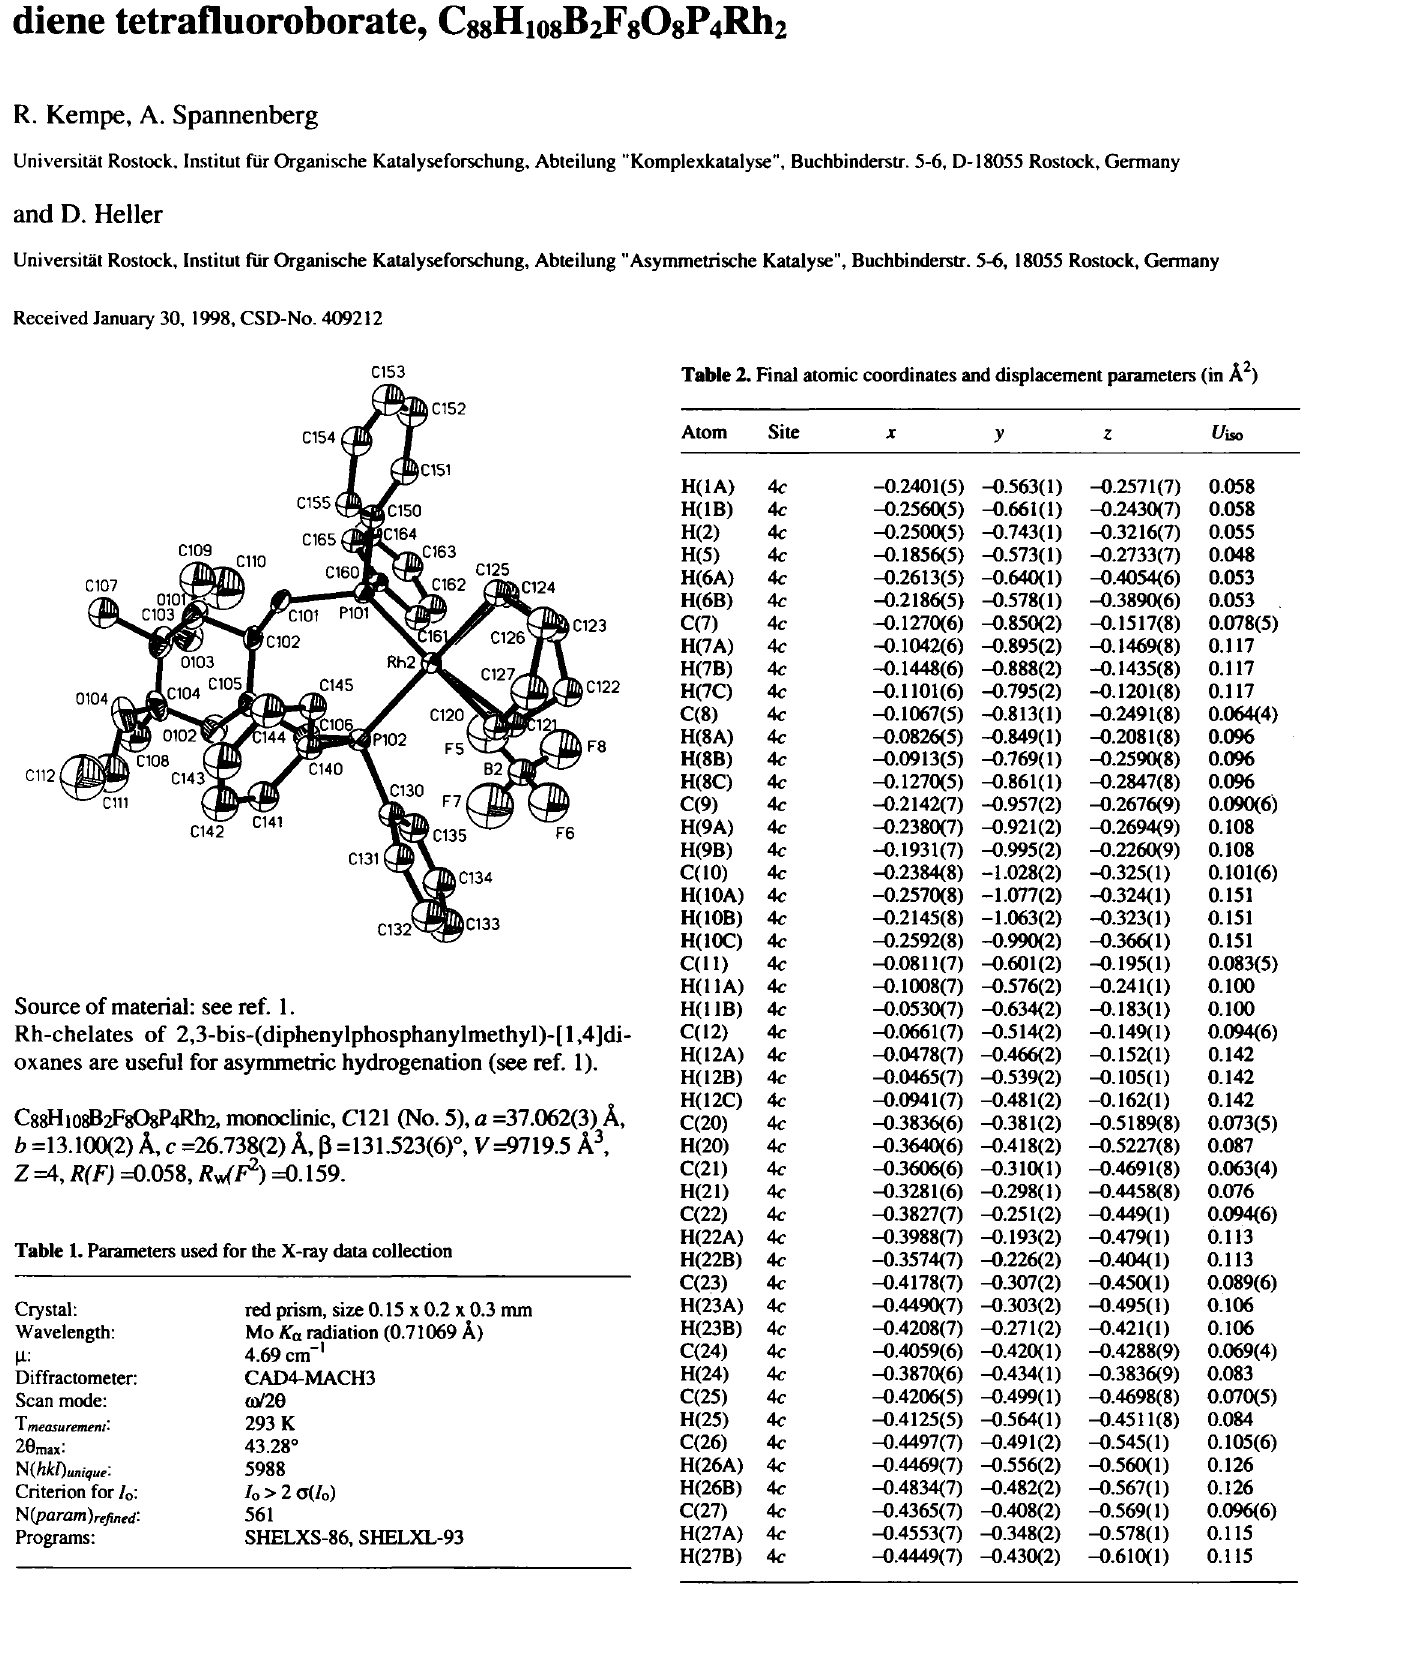
Table 2. Final atomic coordinates and displacement parameters (in